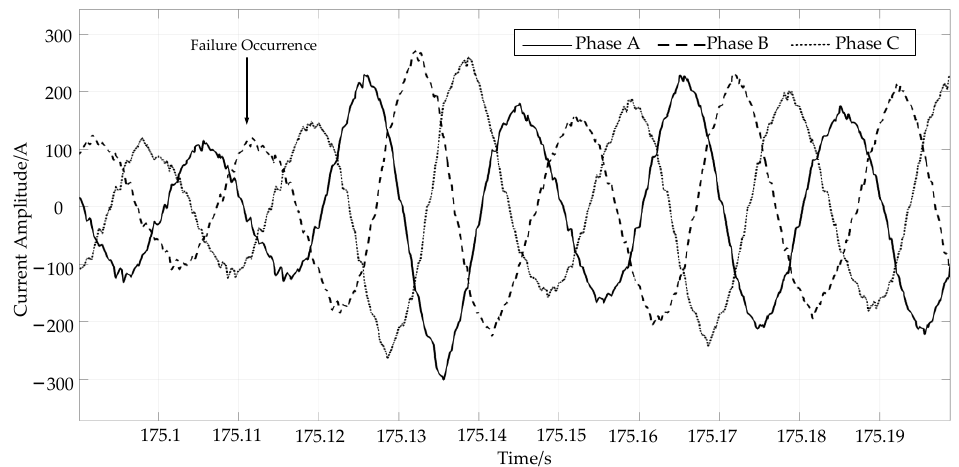
Figure 26. Grid-side current in the case of phase-to-phase short-circuit